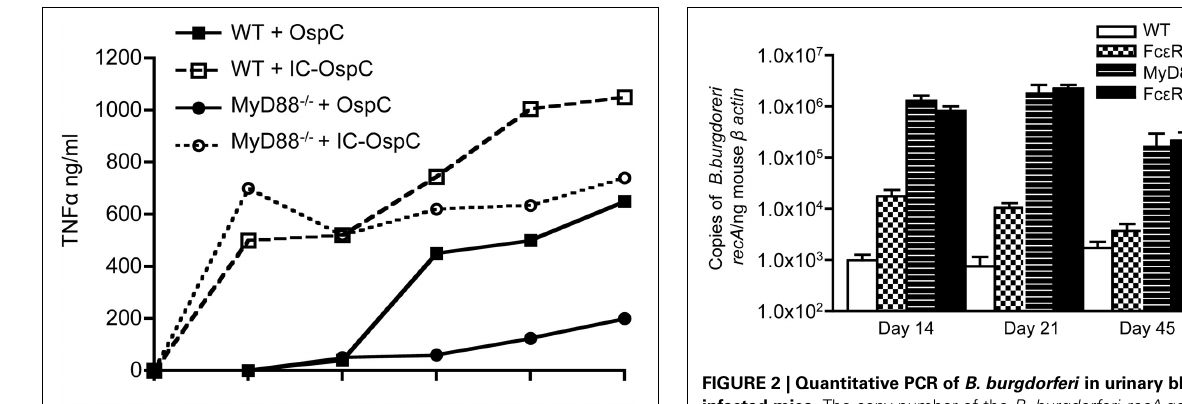
FIGURE 2 | Quantitative PCR of B. burgdorferi in urinary bladders of infected mice. The copy number of the B. burgdorferi recA gene was normalized to the mouse β -actin gene by real-time PCR. Values are averages of 5–11 individual mice. Results are combined from 2 separate experiments. At day 14, the burdens in the Fc ε R γ − / − mice are statistically different from those in the WT mice ( P = 0.0043) and those in the MyD88 − / − and Fc ε R γ − / − MyD88 − / − mice ( P = 0.0029 and P = 0.0095, respectively). At day 21 the Fc ε R γ − / − mice maintain statistically higher burdens than the WT mice ( P = 0.007) but lower burdens than the MyD88 − / − ( P = 0.001) and the Fc ε R γ − / − MyD88 − / − ( P ≤ 0 . 0001). At day 45 there is no difference between the WT and Fc ε R γ − / − mice but the MyD88 − / − and Fc ε R γ − / − MyD88 − / − burdens remain high. All P -values were calculated using the Mann-Whitney